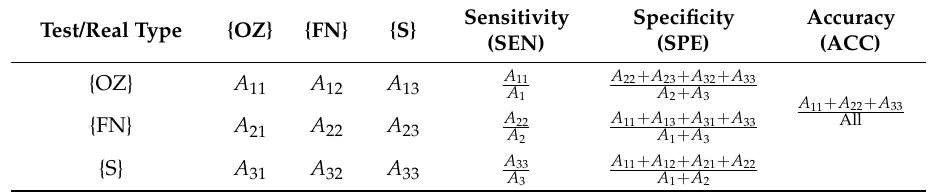
Table 4 for the three-class classification of epilepsy EEGs. Table 4. Definition of the performance classification multiple-indices used in the